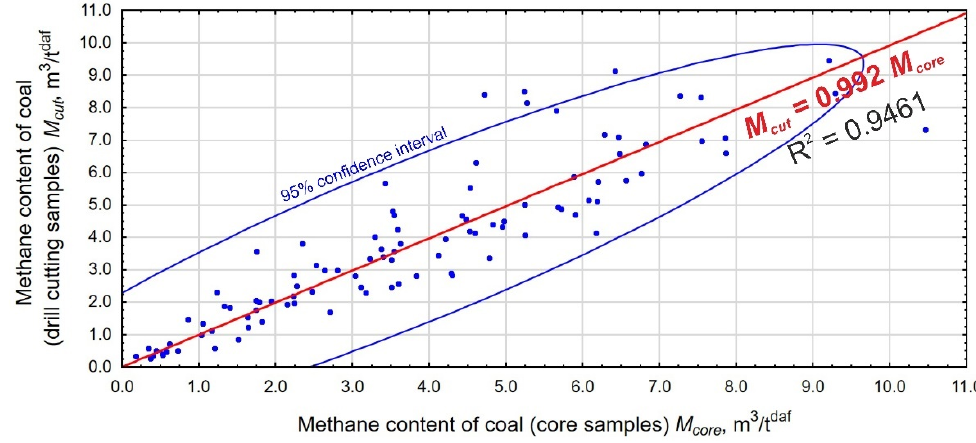
Figure 8. Comparison of methane content of coal based on drill cutting samples and the methane content of coal for the core